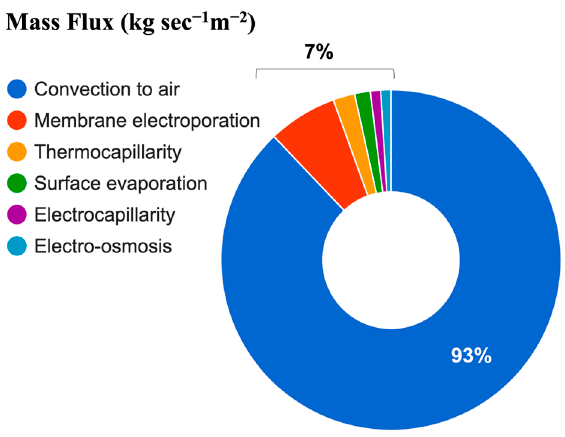
Figure 3. Contribution of different EHD-induced water transport mechanisms to the total mass transfer during the EHD drying process of plant-based materials (adapted from Iranshahi et al. [58]).